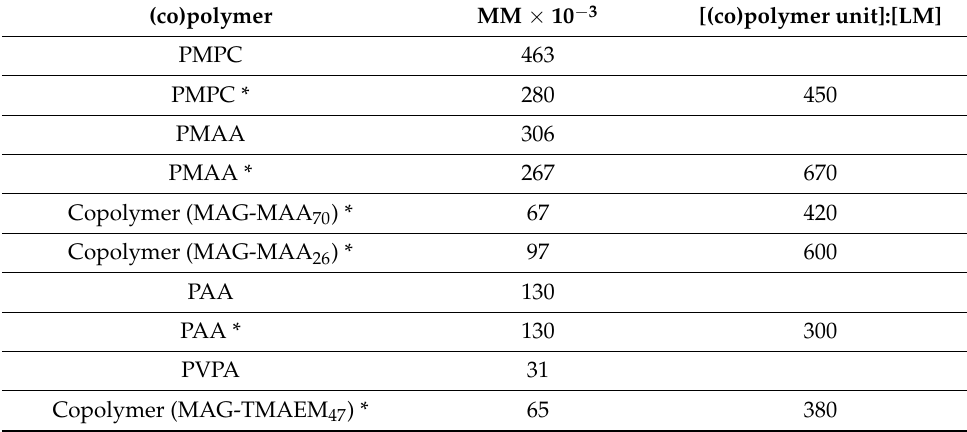
Table 1. Characteristics of the studied polyelectrolytes (copolymer composition, MM, and amount of (co)polymer units per 1 luminescent